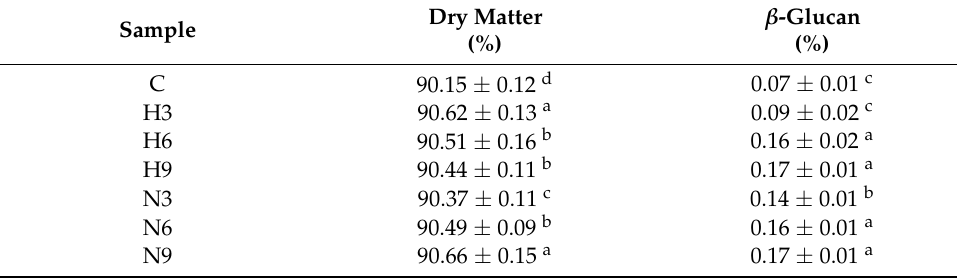
Table 2. Results of dry matter and β -glucan content of the breads analysed.